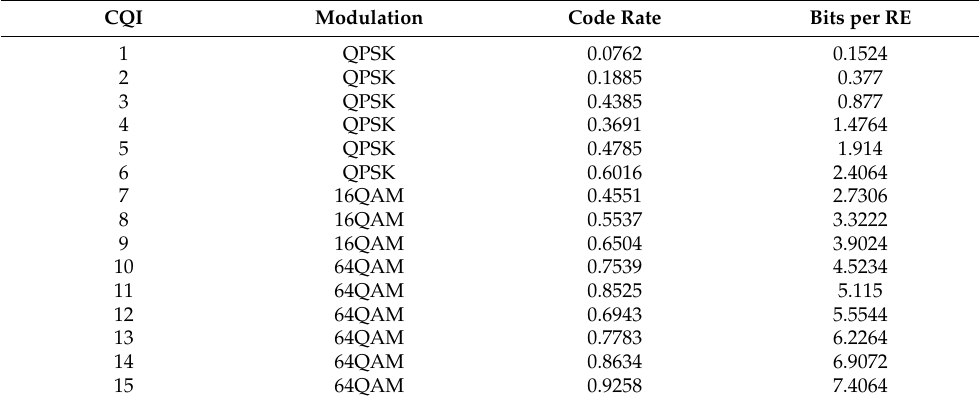
Table 11. CQI-MCS mapping for LTE rel.12 and beyond [52].